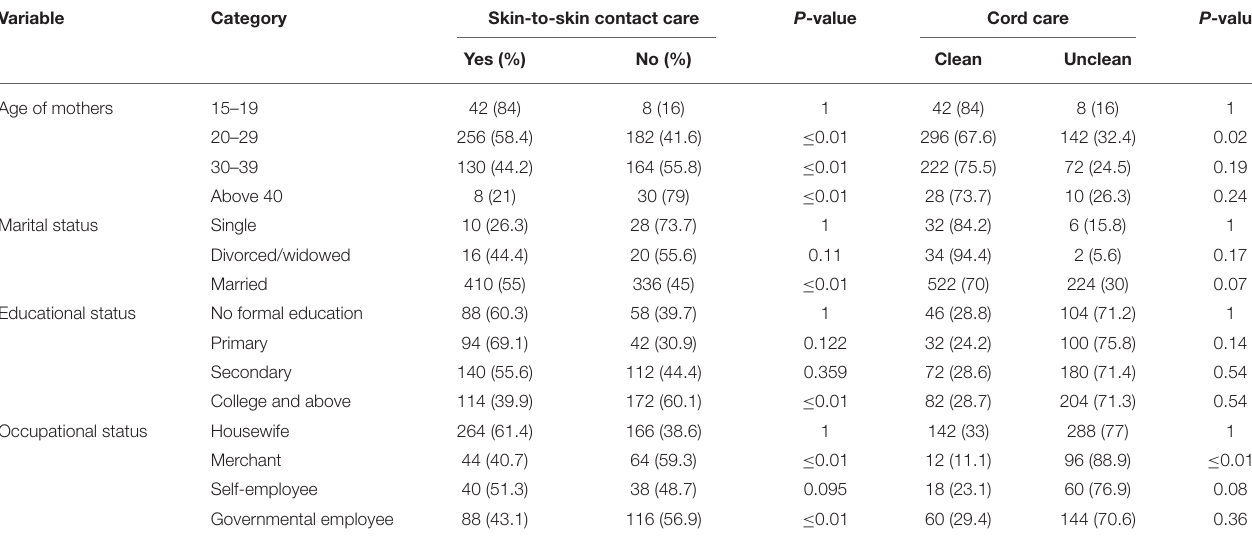
TABLE 1 | Sociodemographic characteristics of post-partum women at public hospitals of eastern Ethiopia, 2021. Variable